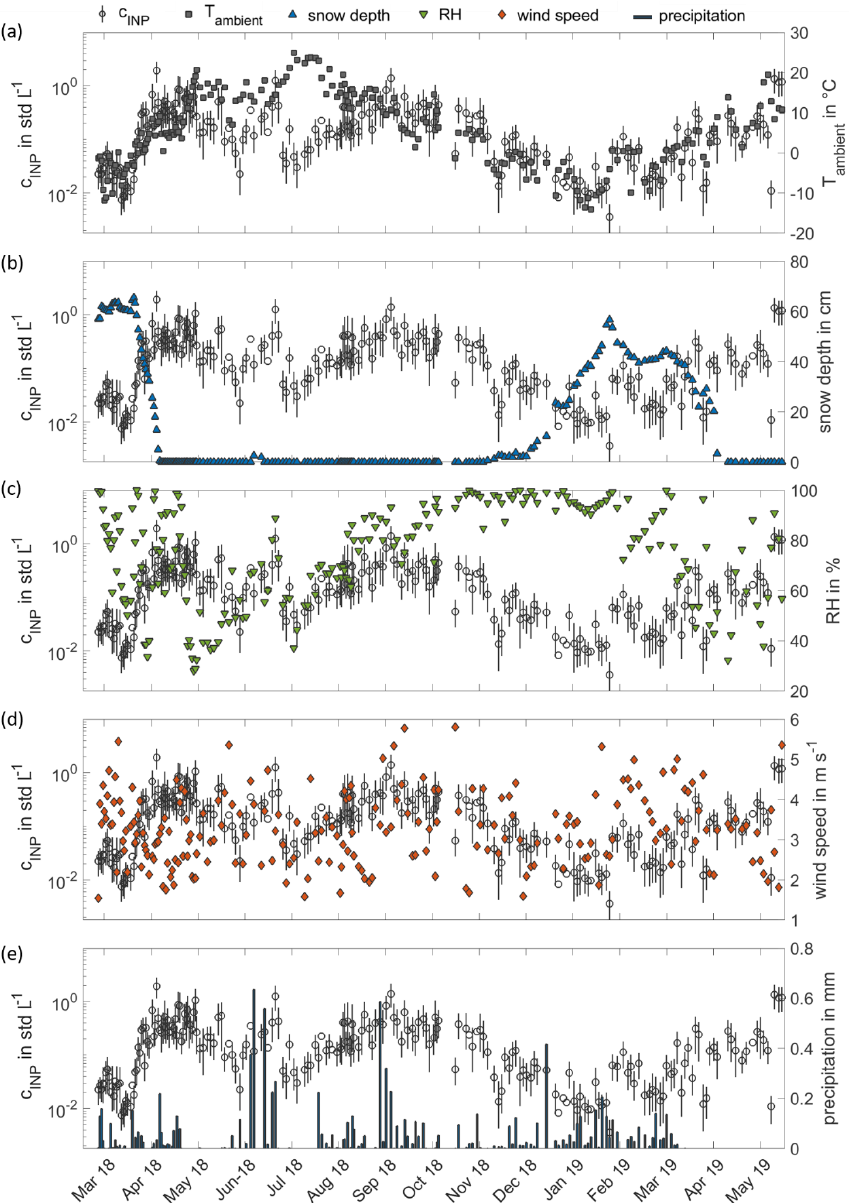
Figure 5. Time series of INP concentrations compared with the time series of different meteorological parameters from 11 March 2018 to 31 May 2019. In panel (a) , the time series of INP concentrations at 257K (circles) is plotted with the ground-level ambient air temperature measured at 4m above ground level (grey squares). In panels (b) , (c) , (d) and (e) , the INP concentrations at 257K are replotted and compared to the measured snow depth (blue triangles), the relative humidity measured at 35m height (green triangles), the wind speed measured at 34m height (orange diamonds) and precipitation (black bars). All meteorological parameters are averaged over the INSEKT filter sampling time